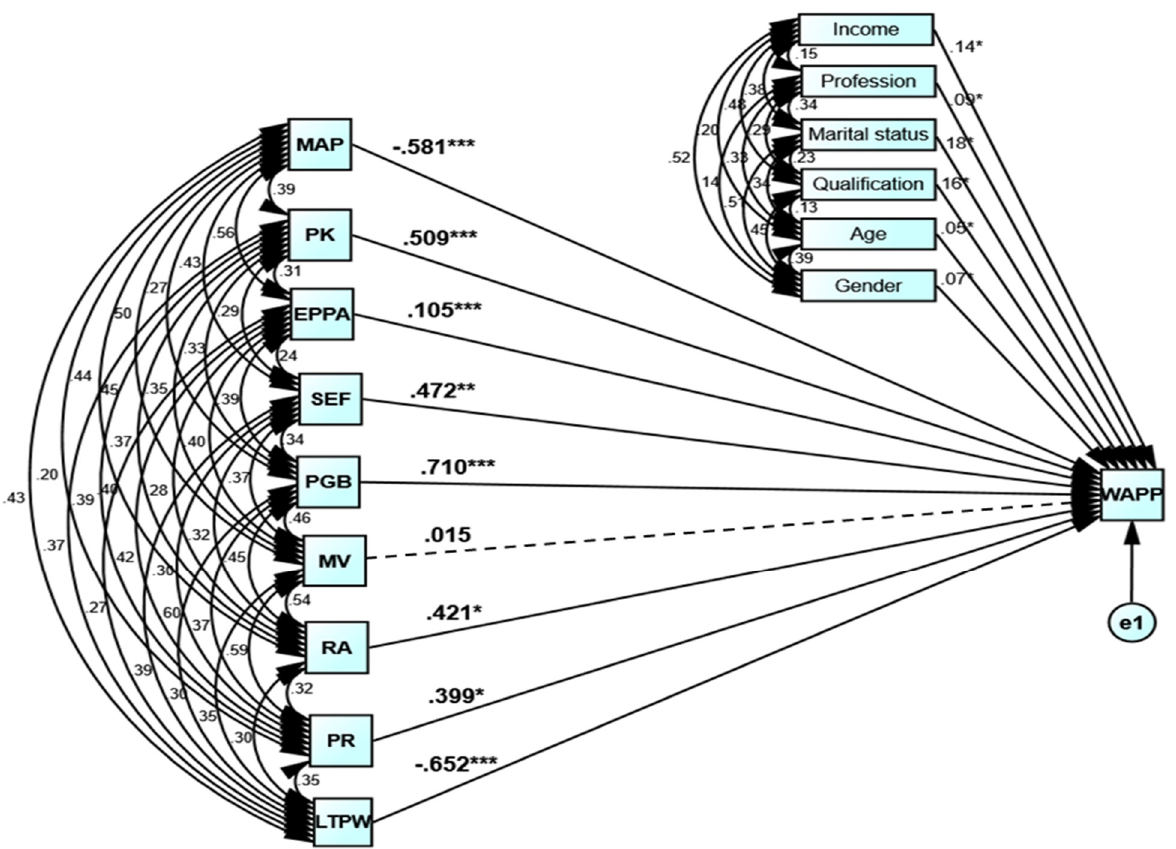
Figure 3. Path modeling ‐ based estimation of coefficients. Notes: * p < 0.10, ** p < 0.05, *** p < 0.01. Solid line denotes significant path, while dashed line denotes insignificant one. Source : Authors’ elaboration.